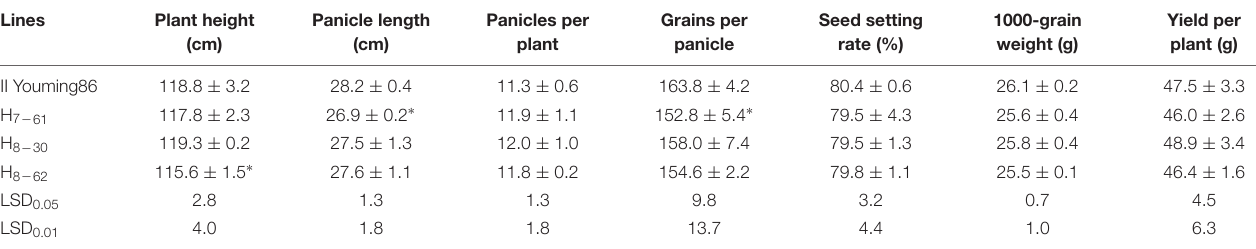
Grains per panicle